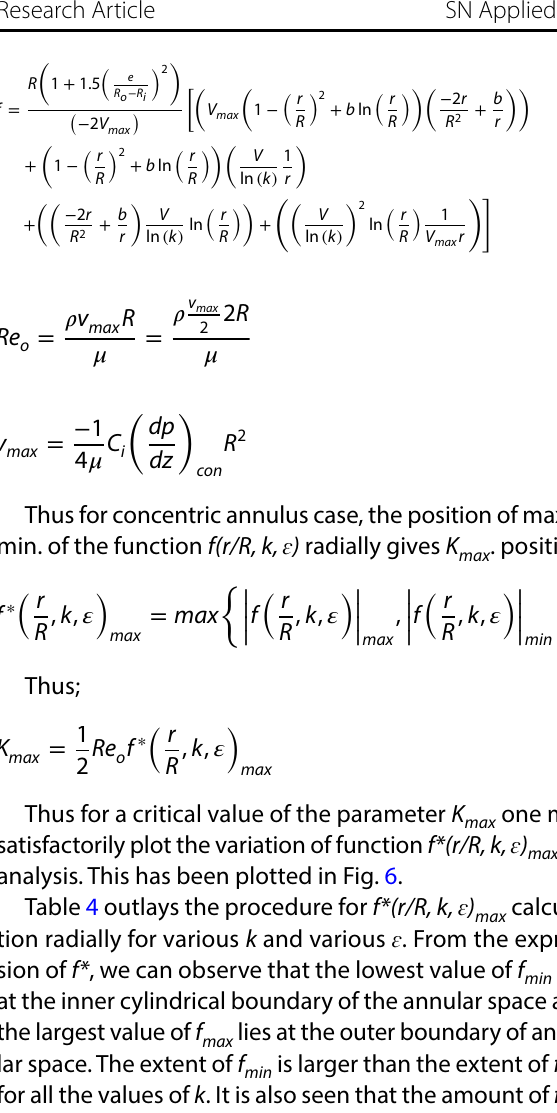
Table 3 Comparison of the Re Dewangan and Sinha [2]) Domain of flow Expression